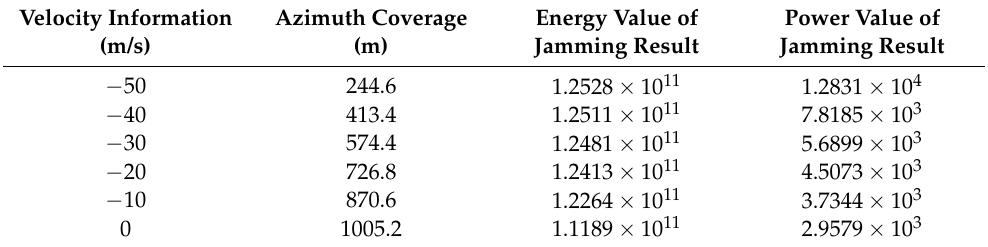
Table 4. Energy value and power value of the suppression jamming results under different velocity information of azimuth motion